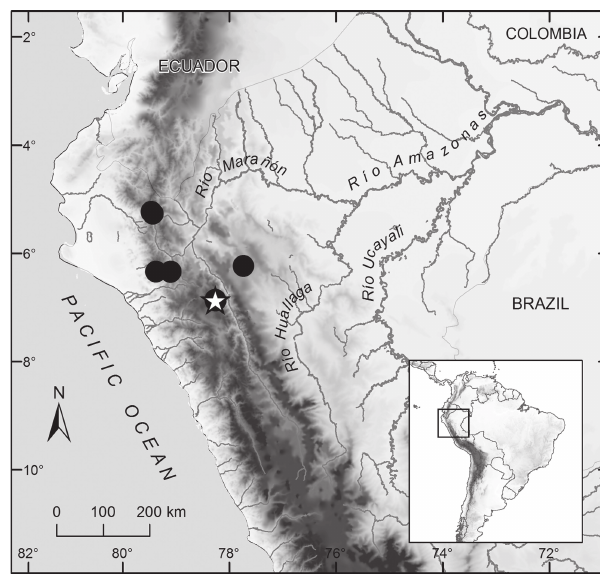
Fig. 2. Geographic distribution of Chaetostoma spondylus . Symbols represent more than one lot, and more than one locality. Star indicates type